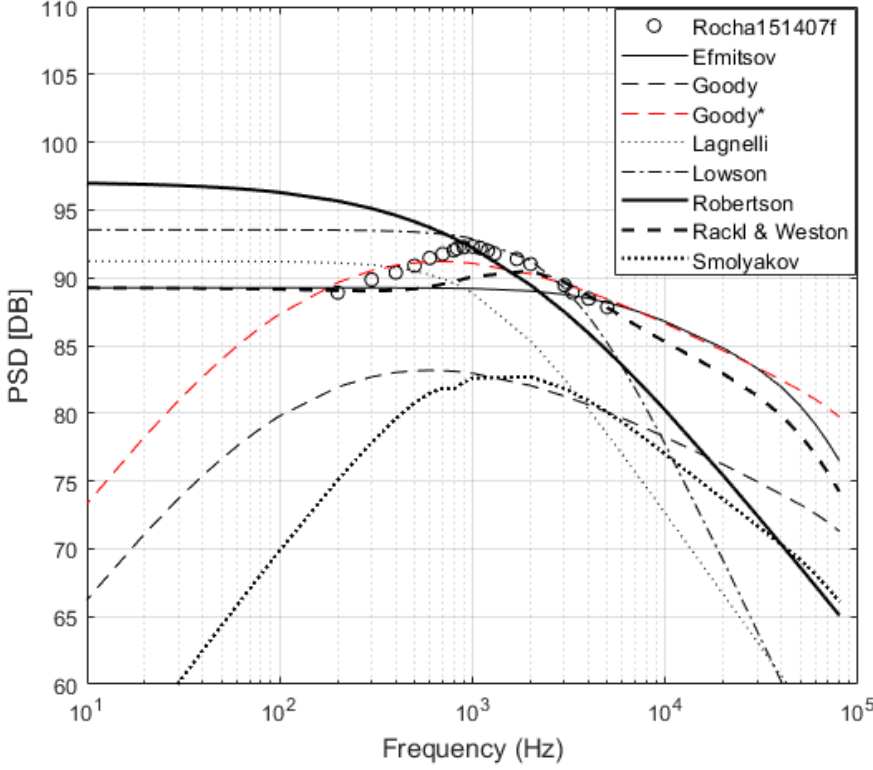
Figure 5. Rocha151407f compared to models, MSE for each model: Efimtsov 4.4, Goody 71.5, Goody* 0.6, Lagnelli 21.1, Lowson 3.6, Robertson 7.3, Rackl and Weston 2.4, Smol’yakov